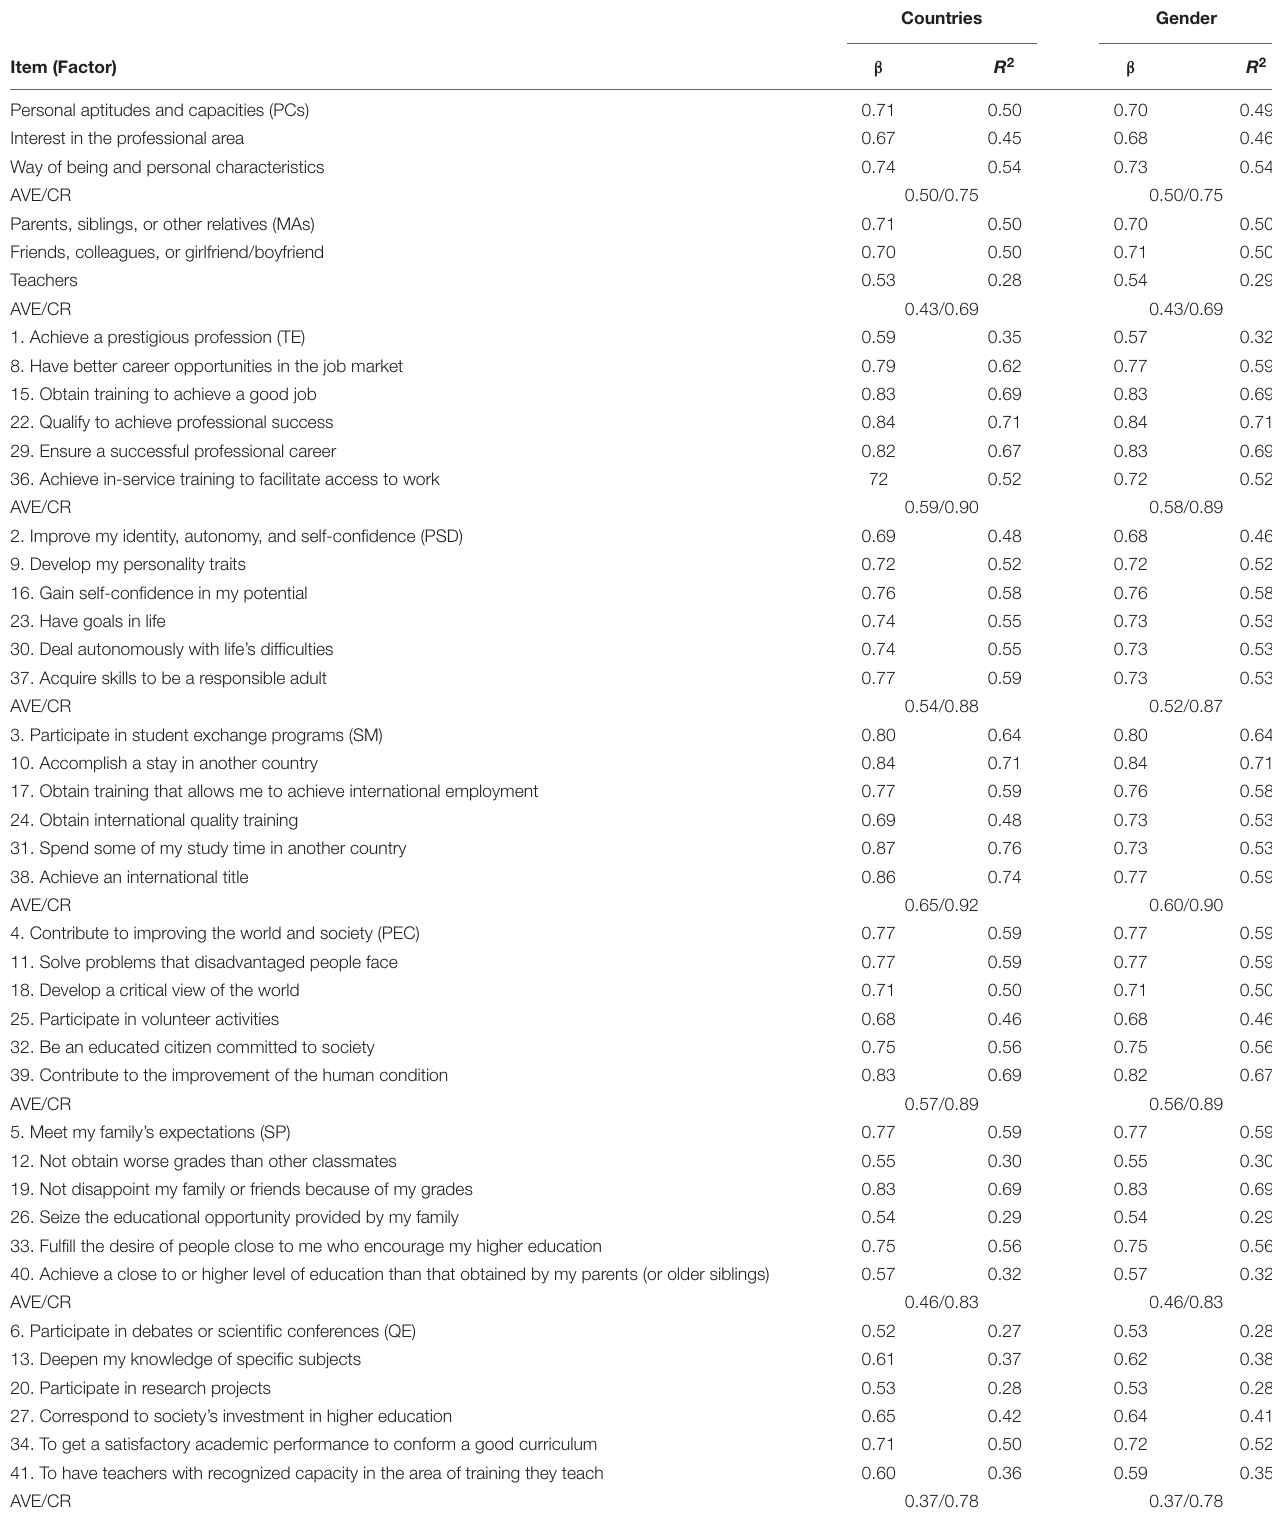
Countries Gender